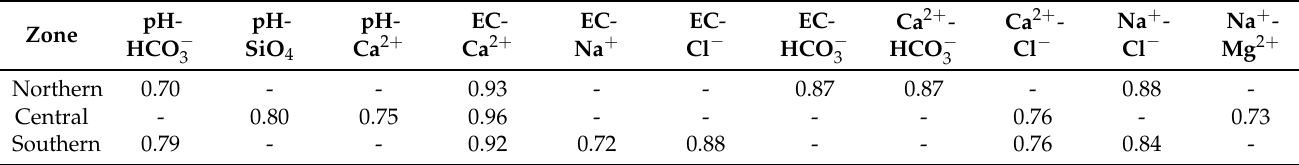
Table 2. Correlation coefficients between the hydrochemical parameters in the groundwater, high- lighting the relationships between them. They were tested at a significance level of p < 0.05 with r > 0.7 and r < 0.5 indicating stronger and weaker correlations [27,45], respectively. Only the correlations with r-values > 0.7 are considered significant and presented